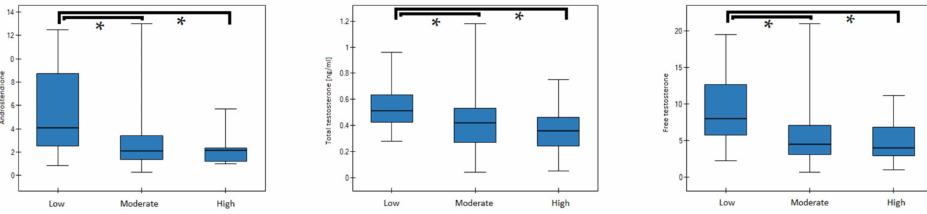
Figure 3. Median (25–75%) of sex hormone concentrations in groups with low, moderate or high PA (work/school). Significant differences are marked by an asterisk